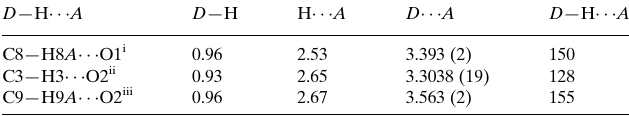
Hydrogen-bond geometry (A˚ , (cid:2)